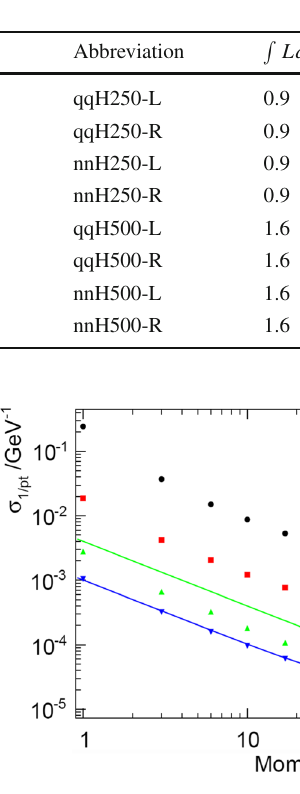
Fig. 3 The transverse momentum resolution for single muon events as a function of the momentum of particles, for tracks with different polar angles. The points show the resolution as obtained from full simulation of the ILD detector, the lines correspond to the design goal of σ 1 / P 2 × 10 − 5 GeV − 1 ⊕ 1 × 10 − 3 /( P t sin θ) for θ = 30 ◦ (green) and θ = 85 ◦ (blue). Taken from Ref.